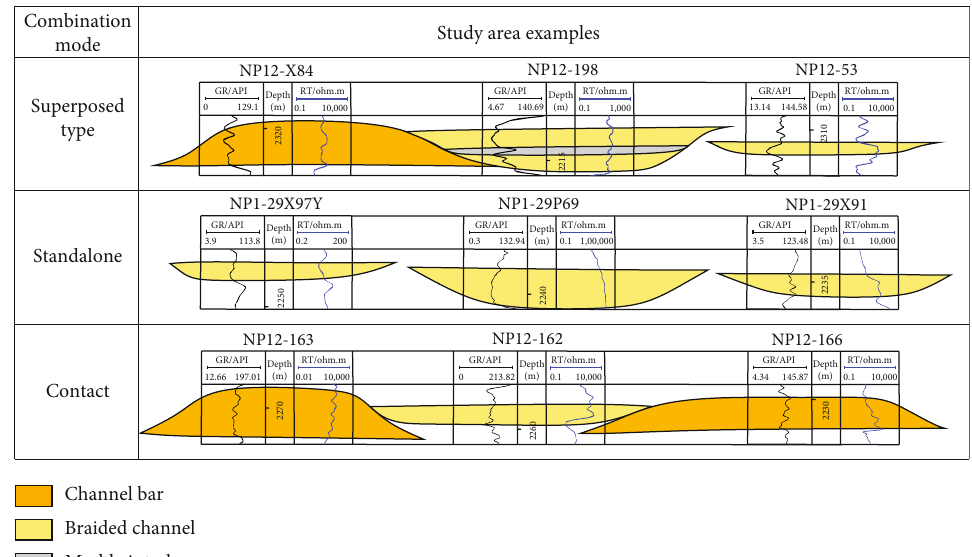
Figure 9: Combination pattern of the sand body in Nanpu 1-29 Area. The determination of the channel bar and the braided channel is mainly based on logging curve morphology and sand body thickness. The scale of channel bar and braided channel was obtained by referring to the scale of modern typical wandering braided river deposits, empirical formula, cores, and logging data in the study